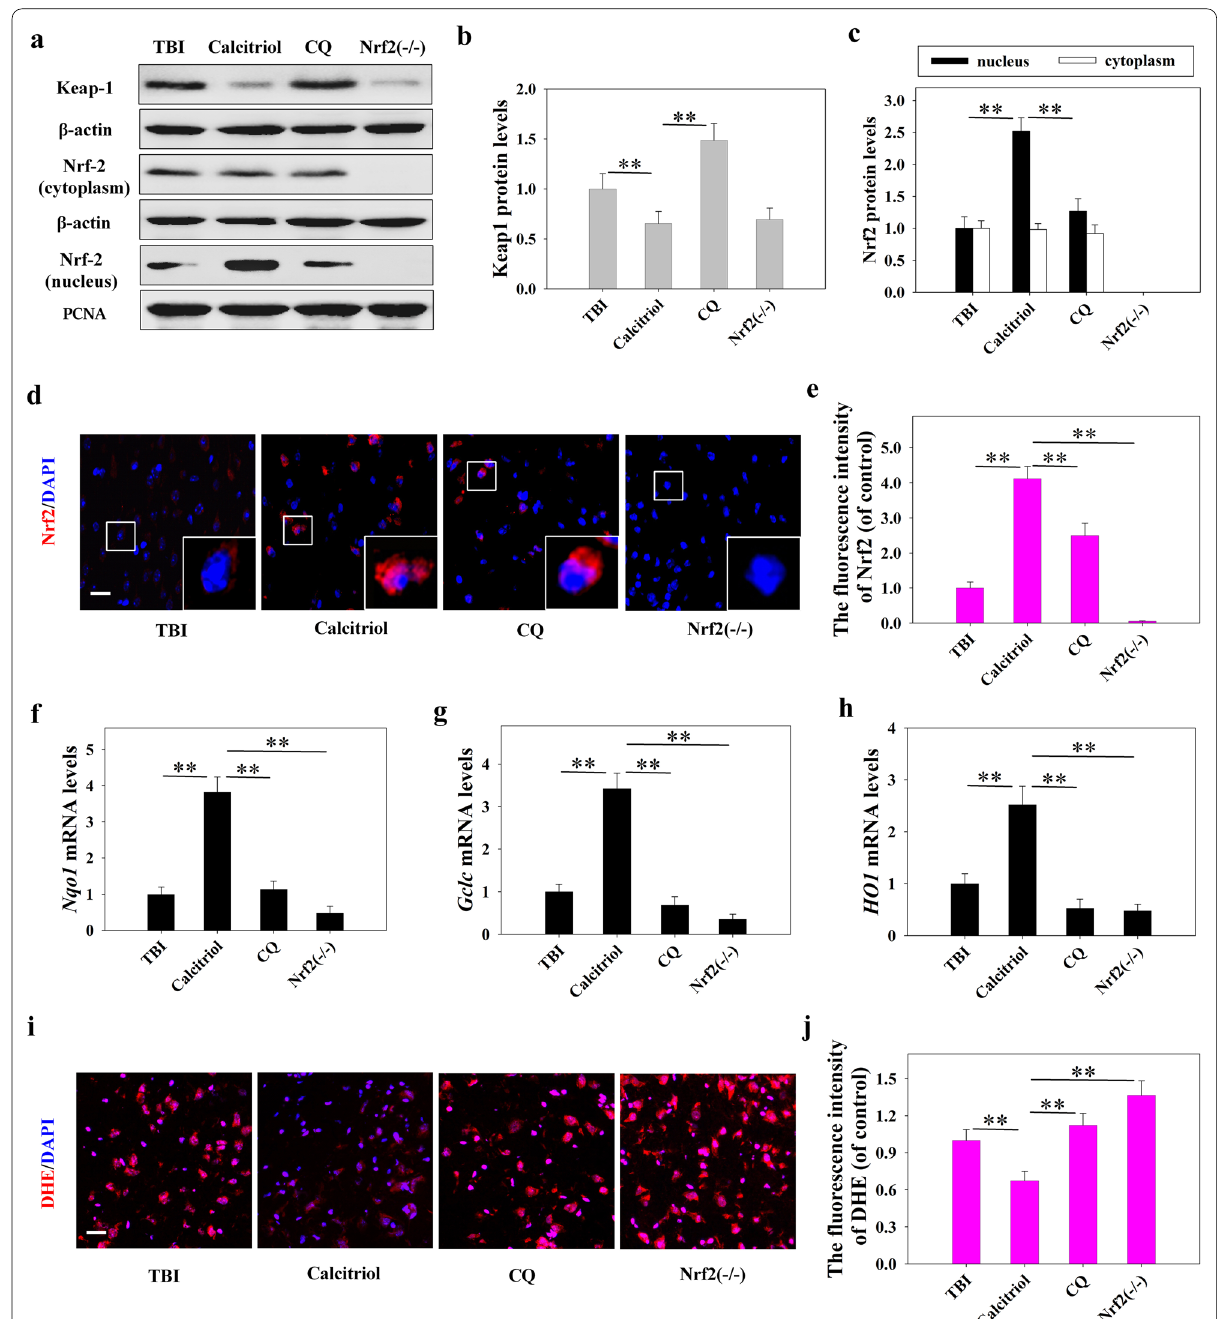
Fig. 6 Inhibiting autophagy abolished calcitriol (0.5 µg/kg)-induced Nrf2 activation following TBI in mice. a Representative images of Western blot staining for Keap1, cytoplasmic Nrf2, and nuclear Nrf2. b Statistical graphs of Keap1 protein expression. c Statistical graphs of expression of Nrf2 in the nucleus and cytoplasm. d , e Representative immunofluorescence images and statistical graphs of Nrf2 translocation (Bar mRNA expression level of Nqo1 . g The relative mRNA expression level of Gclc . h The relative mRNA expression level of HO1 . i , j Representative images and statistical graphs of immunofluorescence assays of dihydroethidium (DHE) (Bar * P < 0.05 and ** P < 0.01 versus the indicated groups. (TBI: TBI model group; Calcitriol: TBI treatment group; Nrf2 − / − : TBI calcitriol Nrf2 knockout + +